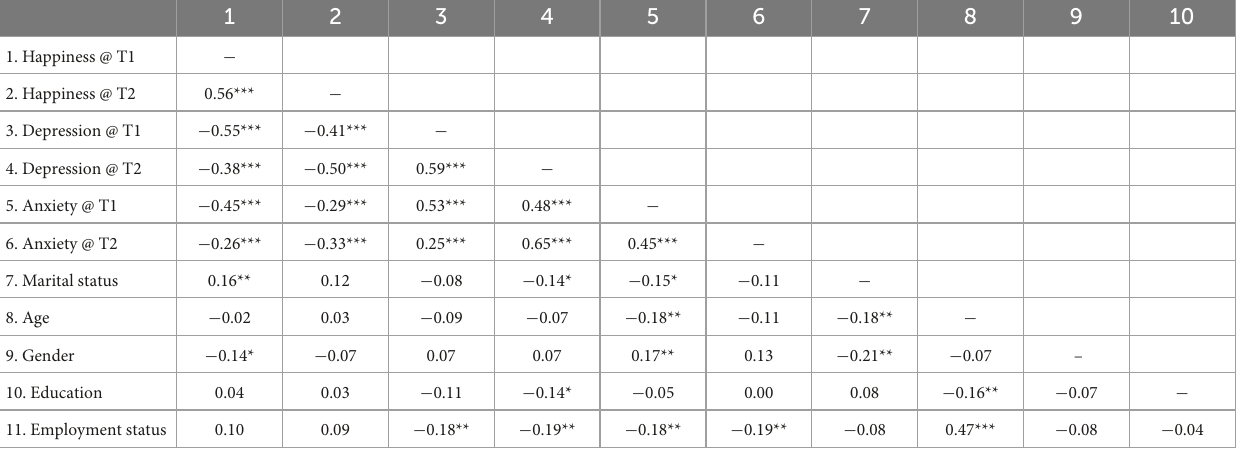
TABLE 5 Bivariate correlations for study 2 with the full sample.